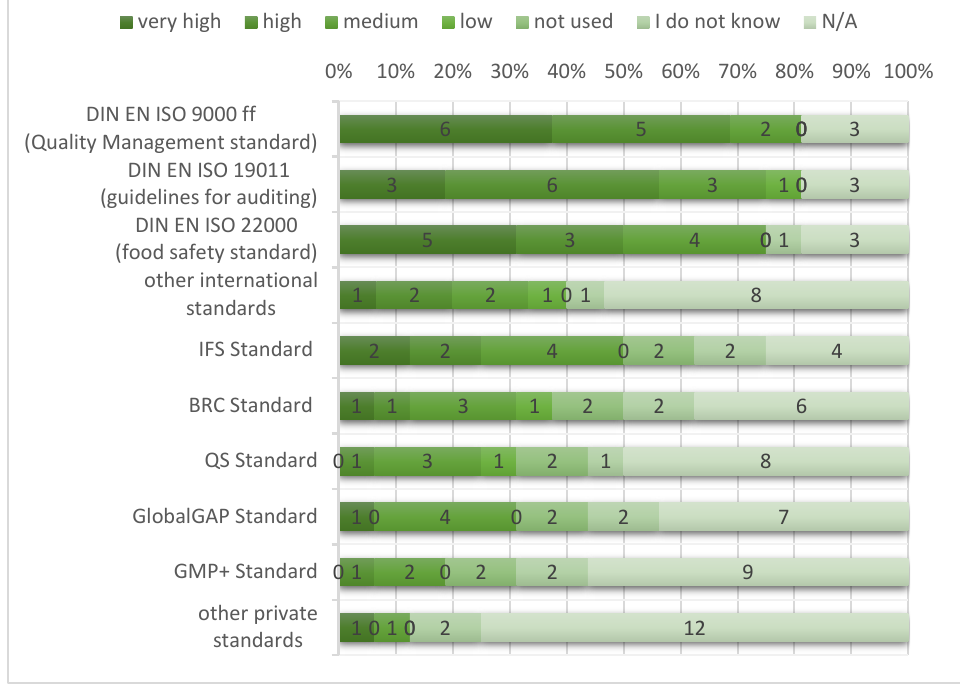
Figure 1. Presentation of the dissemination rate of international quality standards and private standards in the European Union. Multiple answers were possible; n = 159. Source: own calculation. Table 7. EU and US companies ’ awareness of TTIP.